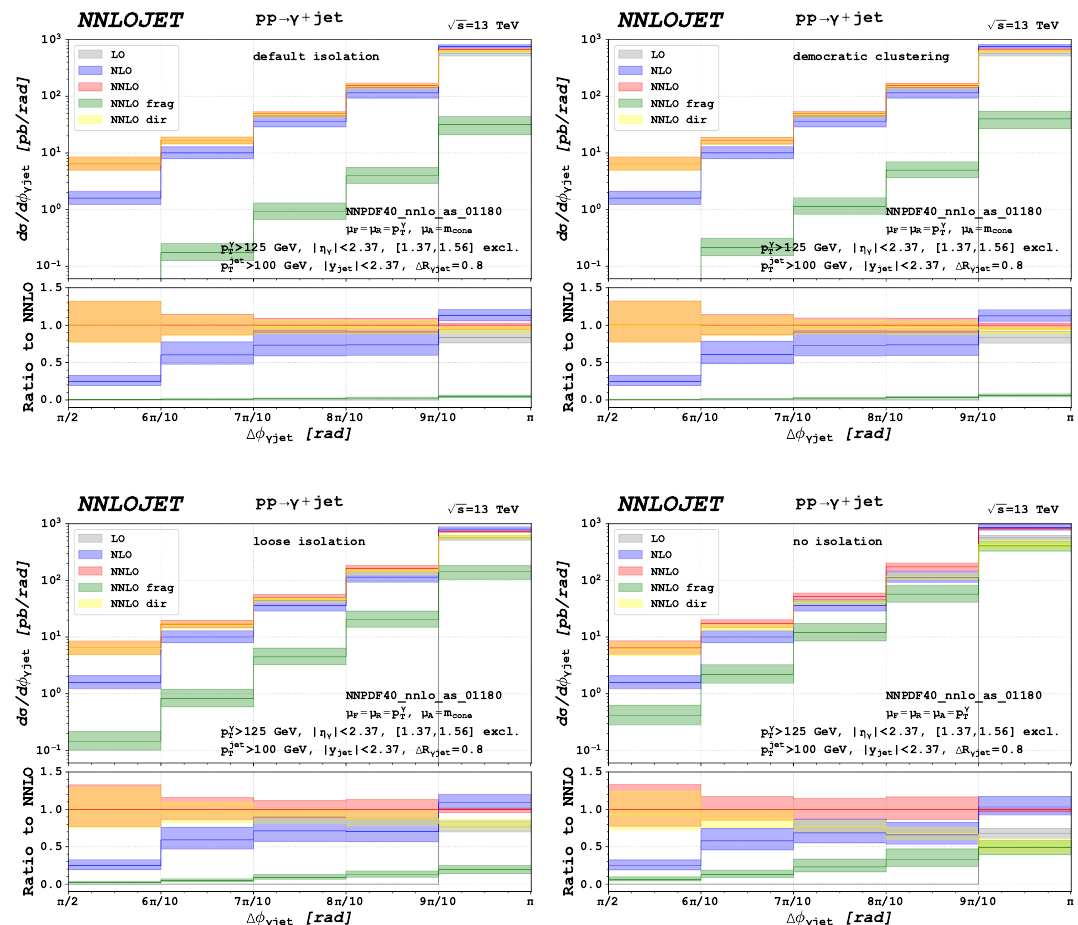
Figure 16. Decomposition of the cross section differential in the azimuthal separation between the photon and the jet. Results obtained with the default isolation, a loose isolation, democratic clustering and without isolation are